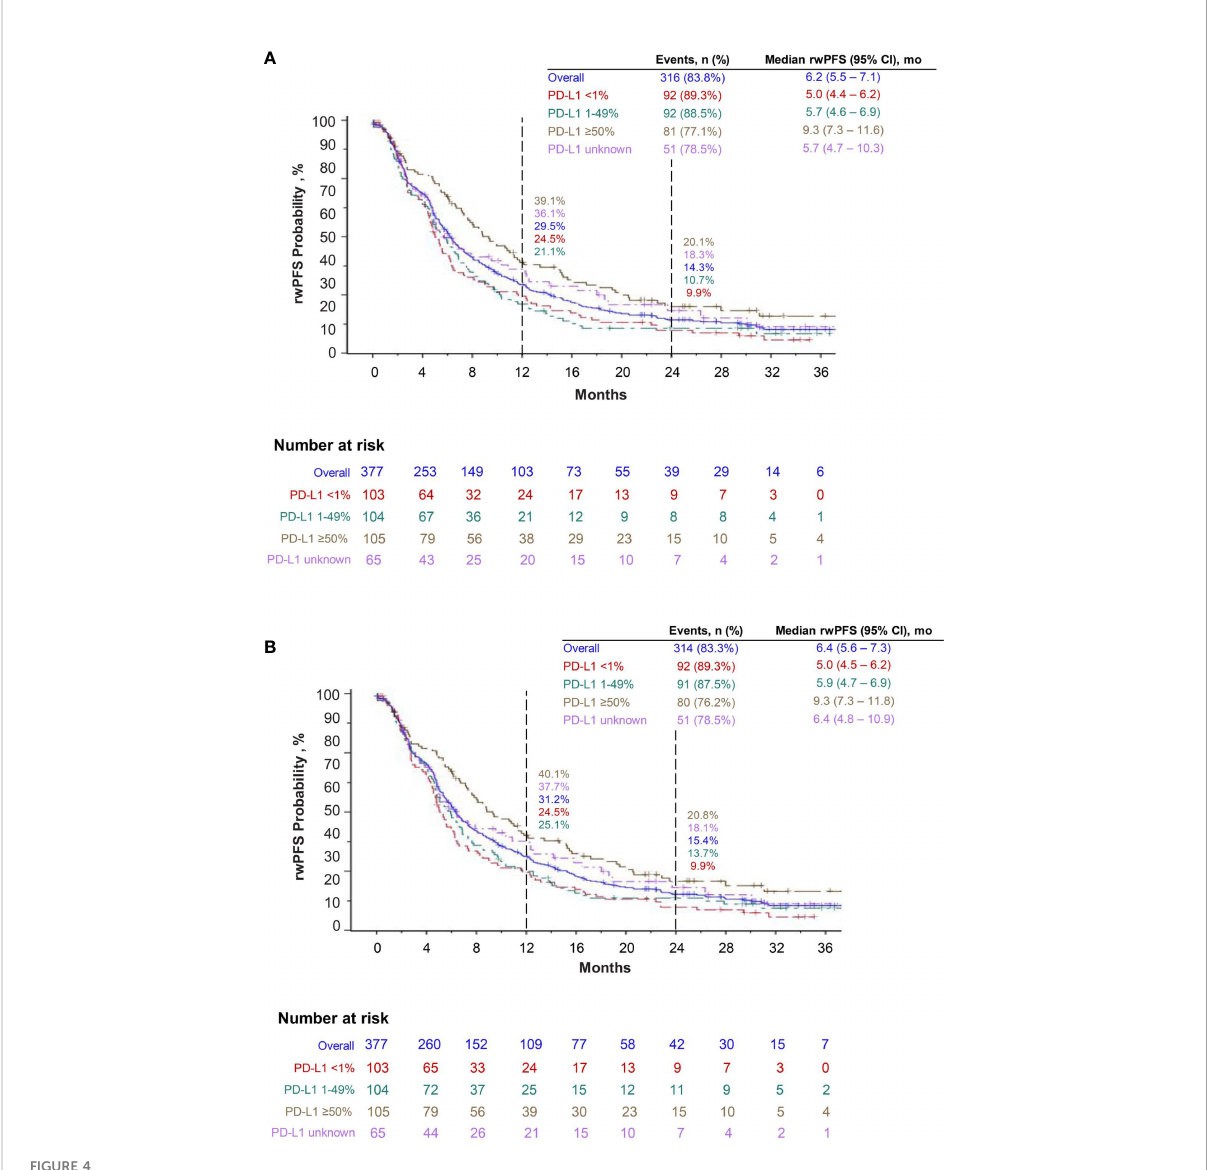
FIGURE 4 Real-world progression-free survival (rwPFS) with pembrolizumab plus pemetrexed and carboplatin (A) and sensitivity analysis of real-world progression-free survival, censoring pseudoprogression (B)